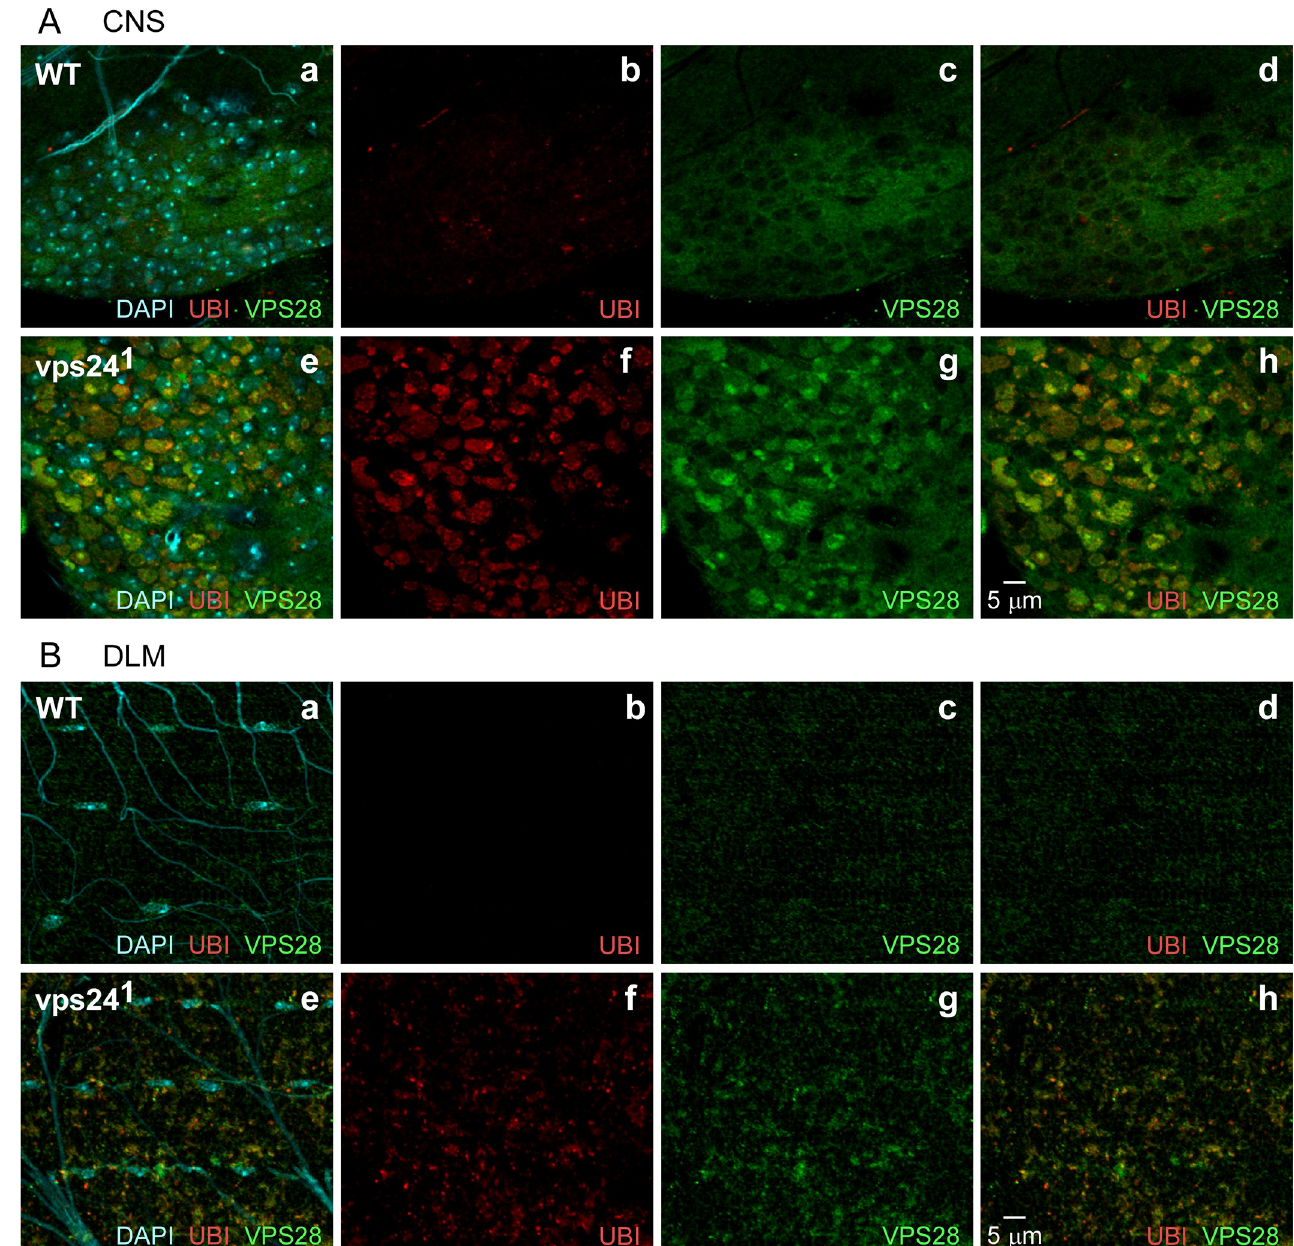
Fig 5. An ESCRT-I component, VPS28, associates with ubiquitin-positive compartments. Confocal immunofluorescence images of CNS neurons (A) and DLMs (B) from WT (a-d) or the vps24 mutant (e-h) . Endogenous VPS28 was detected using an anti-VPS28 antibody. In both neurons and muscle, VPS28 is highly colocalized with ubiquitin-positive compartments and also exhibits a broader diffuse pattern. Only the diffuse VPS28 pattern was observed in neurons lacking ubiquitinated protein deposits. Thus ESCRT-I and III complexes may cooperate in clearance of ubiquitin-positive compartments.